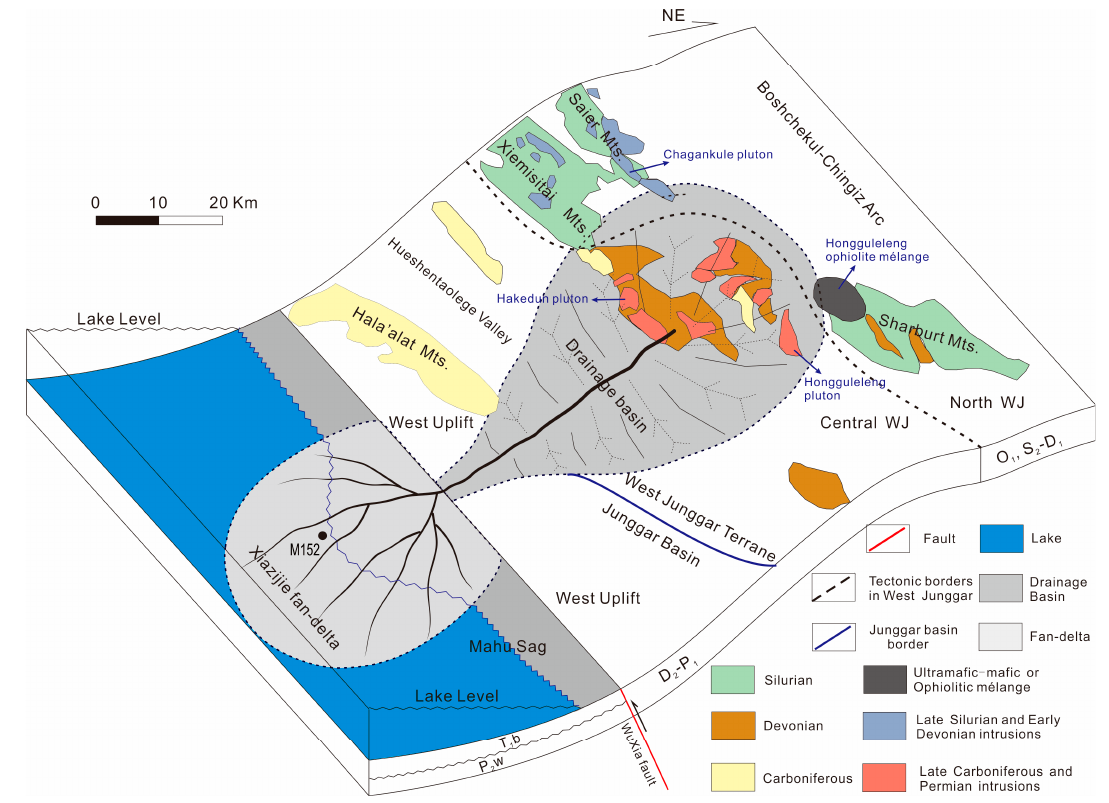
Figure 10. Simplified source to sink system map of the Xiazijie fan-delta.